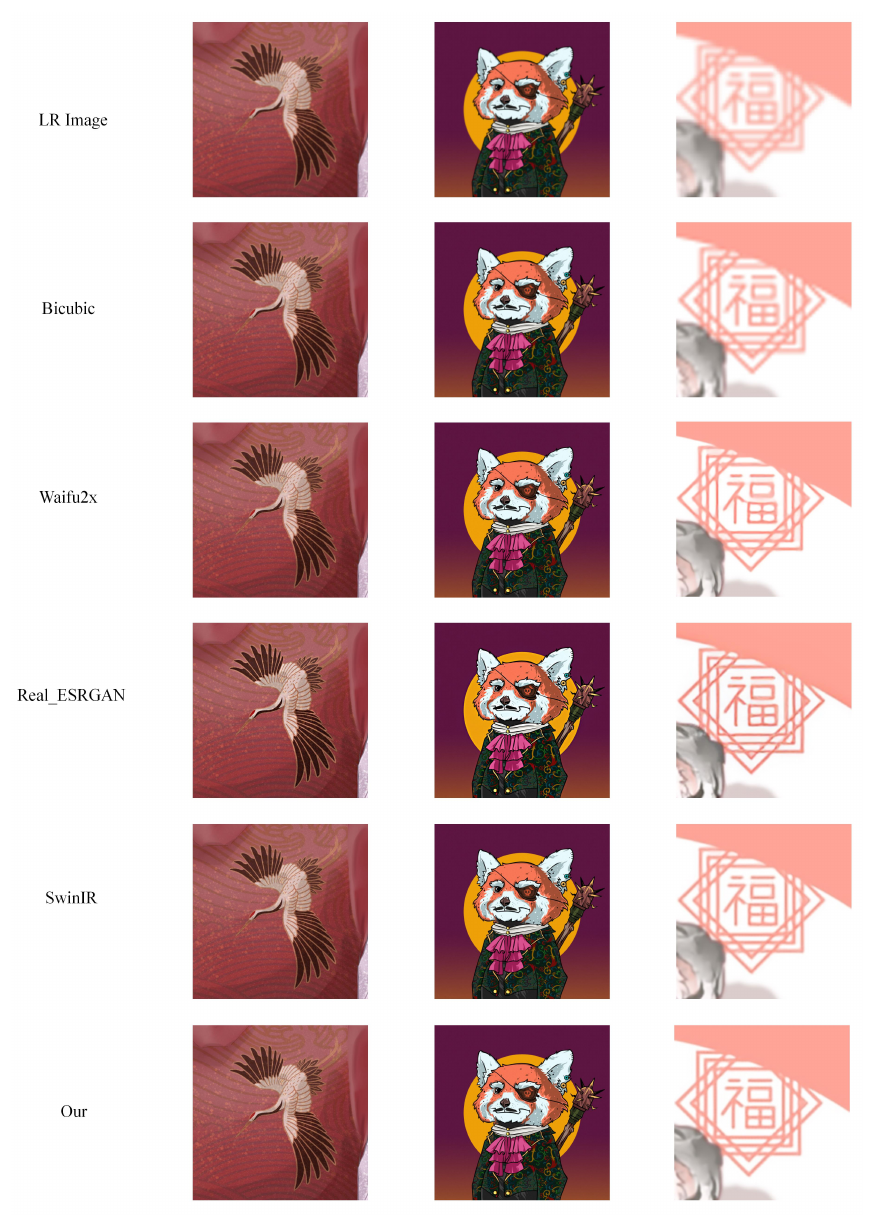
Figure 26. The results of three example images from the Multi-level anime83 test dataset for different super-resolution methods at 4 × super-resolution